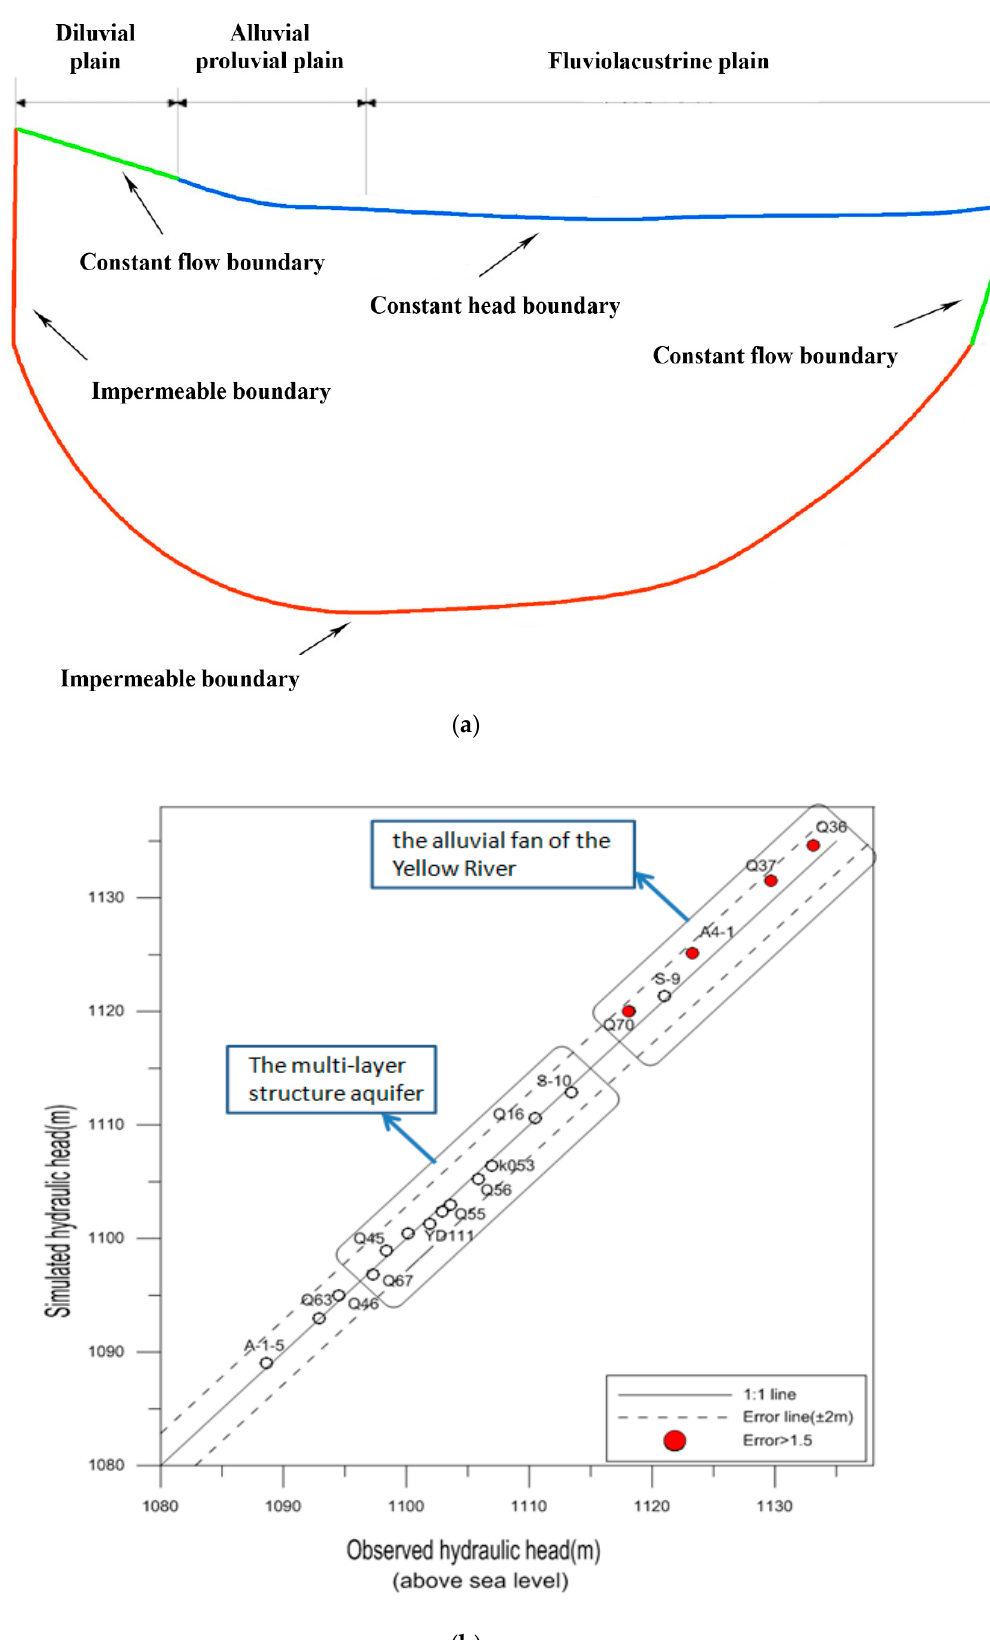
Figure 3. ( a ). Boundary conditions of Profiles 1 and 2. ( b ). Comparison of observed and simulated hydraulic head (above sea level) values along the Yellow River.